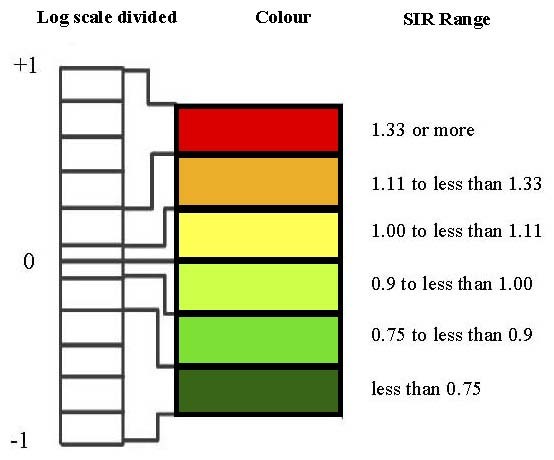
Standardised incidence rate (SIR) categories.